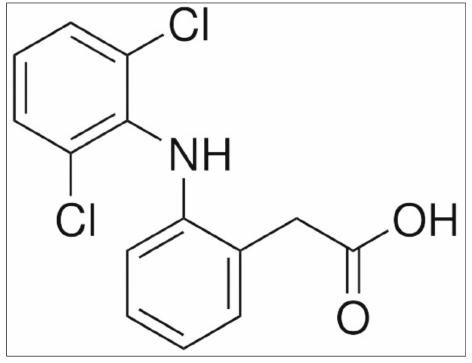
Figure 1. Diclofenac sodium (DS)